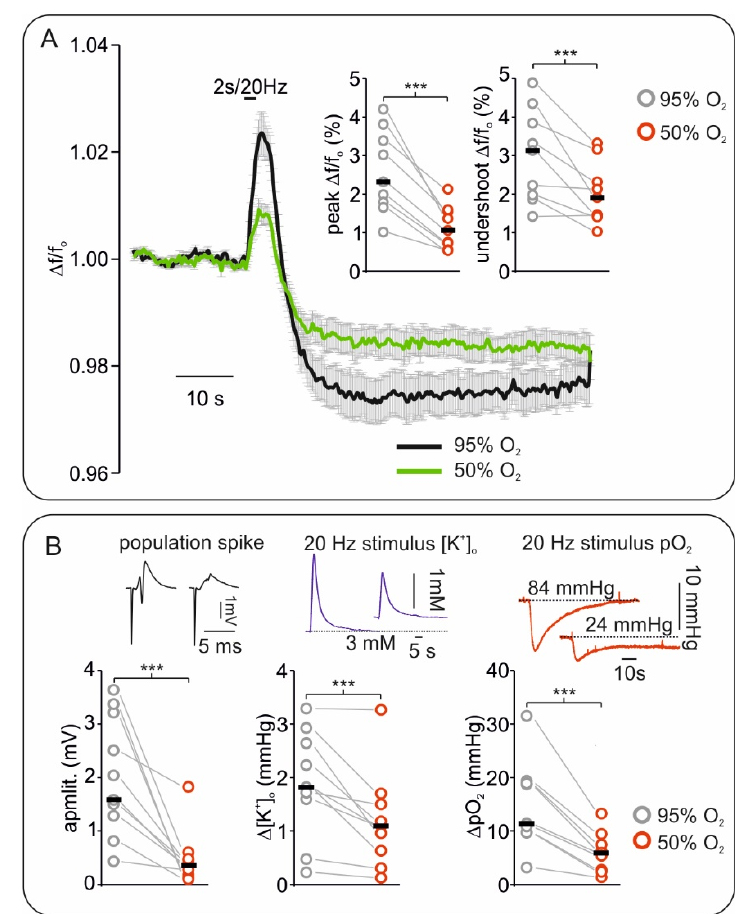
Figure 2. Effects of hypoxia on stimulus induced Flavin adenine dinucleotide (FAD) signals correlates with changes in electrophysiology. ( A ) Averaged curve of stimulus induced FAD transients elicited by 20 Hz/2 s stimulus train. Compared with the control (black curve), peak (oxidation) and undershoot (reduction) FAD response to stimulation decreased during hypoxia (green curve, error bars represent standard error). Right corner on top: plot of changes in FAD oxidative peaks and reductive undershoots during 95% and 50% oxygenation (grey circles: control, and red circles: hypoxia, black lines: median values). ( B ) Plots and exemplary traces of stimulus induced field potential, extracellular potassium ([K + ] o ) and tissue oxygenation (pO 2 ) changes during hypoxia. Left, the amplitude of single pulse stimulus-induced population spikes (example on top) decreased during hypoxia suggesting impaired synaptic transmission. Middle: [K + ] o increases elicited by 20 Hz tetanus decreased in amplitude under hypoxia. Right: pO 2 dips simultaneously recorded with tetanus-induced FAD and [K + ] o changes decreased. Plots: grey circles: control, red circles: hypoxia, and black lines: median values. All parameters were recorded simultaneously, n = 9, *** = p < 0.001.